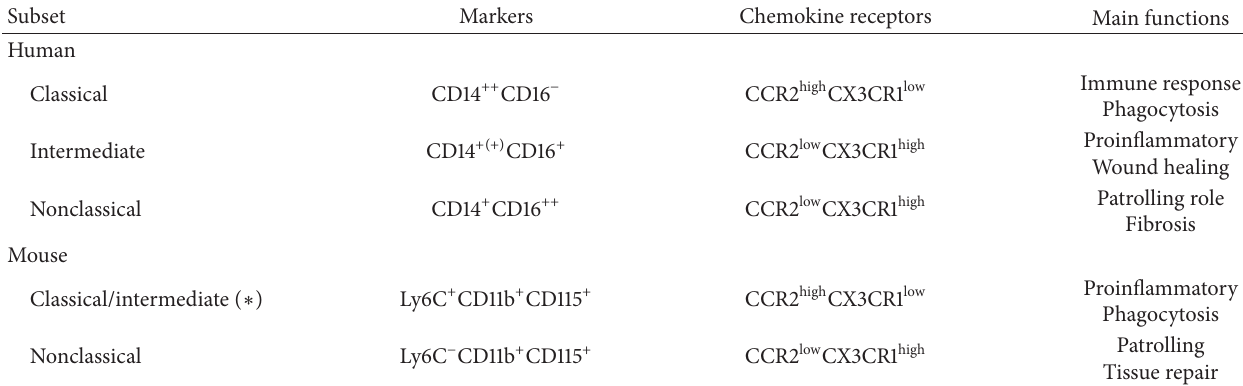
Table 1: Human monocyte subsets and their murine